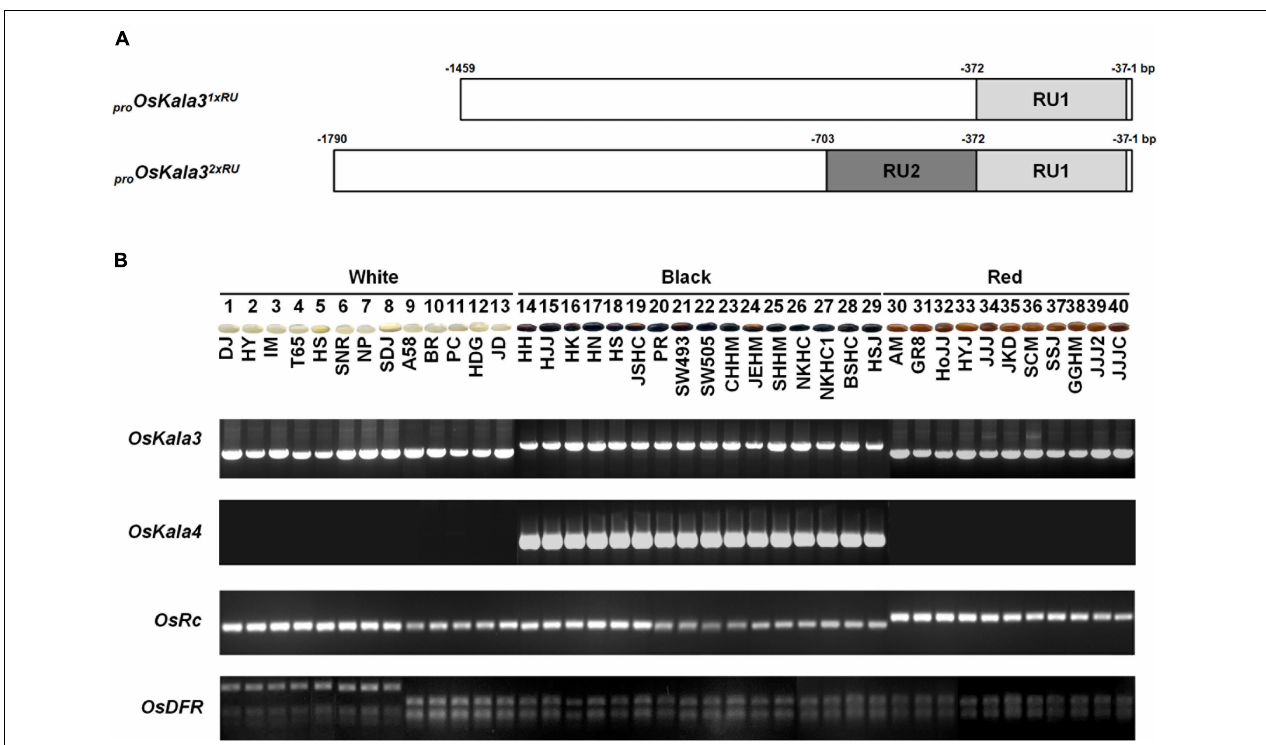
FIGURE 7 | Variation at OsKala3 , OsKala4 , OsRc , and OsDFR predicts pericarp color across 40 rice cultivars. (A) Schematic representation of OsKala3 promoter region. The light gray box and dark gray box indicate RU1and RU2, respectively, in the OsKala3 promoter region. The position of the RU is indicated relative to the ATG translation start site. (B) Representative photographs of rice seeds showing pericarp colors for the indicated cultivars (top). Genotyping results of the 40 rice cultivars with the and InDel markers designed against OsKala3 , OsKala4 , and OsRc and CAPS marker designed against OsDFR